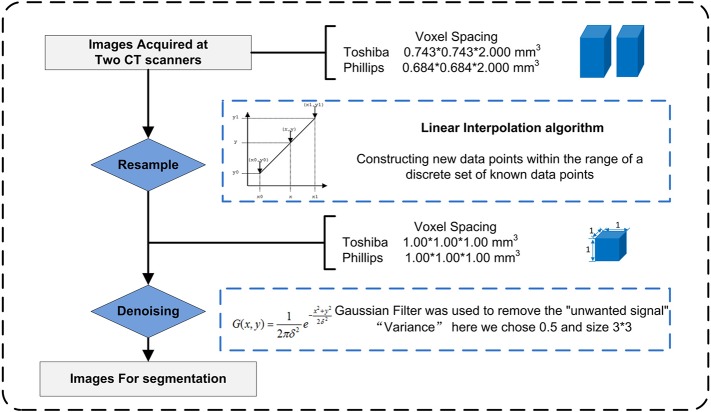
Image preprocessing.